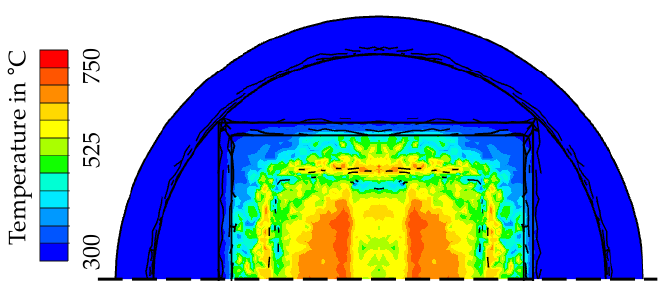
Figure 16. Temperature field of die type 2 at the end of the forming process.